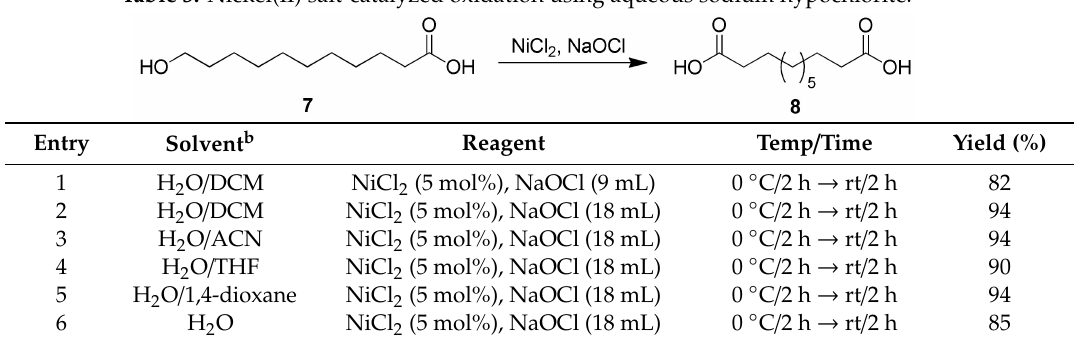
Table 3. Nickel(II) salt-catalyzed oxidation using aqueous sodium hypochlorite.